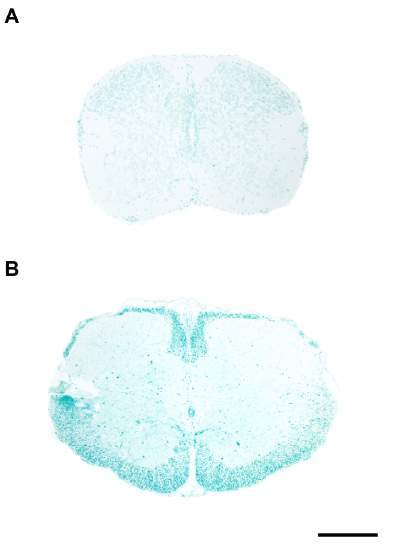
Figure 6. Myelin staining in the developing spinal cord of Monodelphisdomestica . Transverse sections through thoracic spinal cord of P8 (A) and P29 (B) spinal cord stained with Luxol fast blue (LFB). There was no LFB stained myelin at P8 (A) but relatively well- developed myelin was present at P28 (B). However even at P28 the myelination is only beginning to appear (first detected between P21 and P28) and does not reach adult levels until several weeks later (not illustrated). Dorsal is uppermost. Scale bar is 500 m